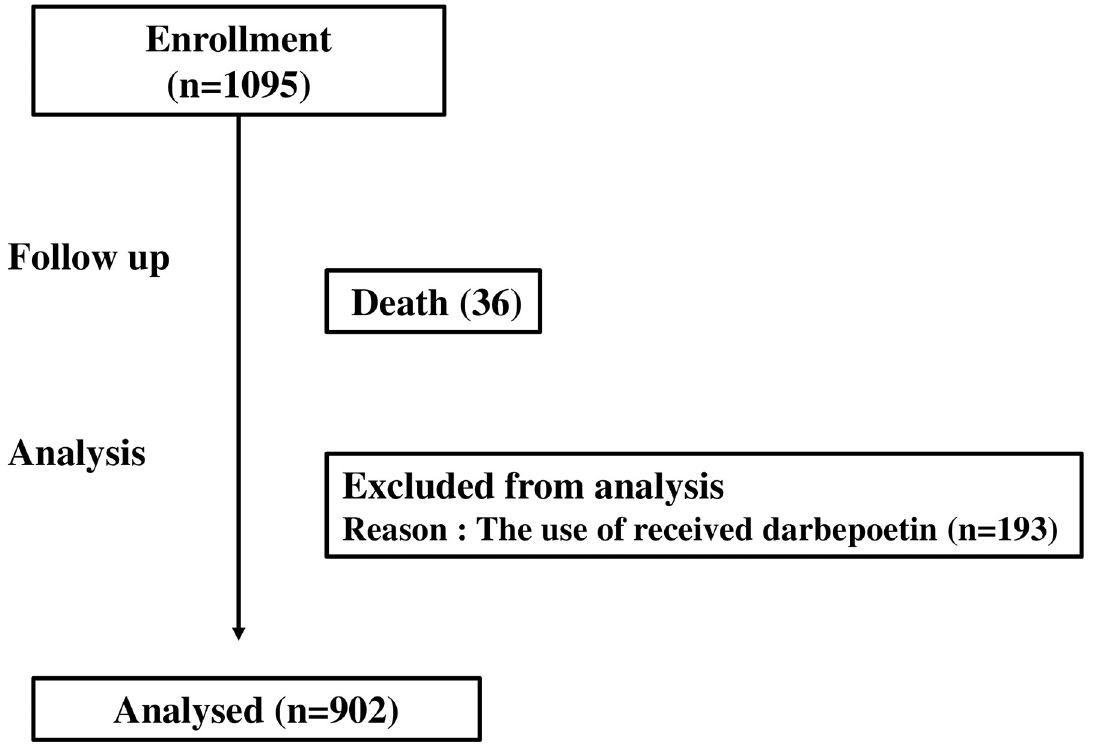
Fig 1. Flow diagram of the progress of this